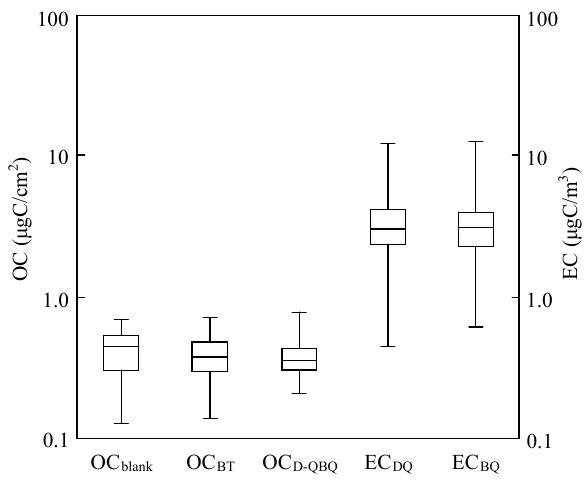
Fig. 5. Concentration of filter blank (OC blank ), denuder break- through (OC BT ), and OC measured by denuded backup quartz filter (OC D - QBQ ); EC concentrations measured by denuded (EC DQ ) and Figure 5. Concentration of filter blank (OC blank ), denuder breakthrough (OC BT ), and OC undenuded (EC BQ ) quartz filter are also shown. The boundary of measured by denuded backup quartz filter (OC D-QBQ ); EC concentrations measured by denuded the box closest to 0.1 indicates the 25th percentile, the line within (EC DQ ) and undenuded (EC BQ ) quartz filter are also shown. The boundary of the box closest to the box marks the median, and the boundary of the box farthest from 0.1 indicates the 25 th percentile, the line within the box marks the median, and the boundary of the 0.1 indicates the 75th percentile, whiskers above and below the box box farthest from 0.1 indicates the 75 th percentile, whiskers above and below the box indicate the indicate the maximum and maximum and minimum.